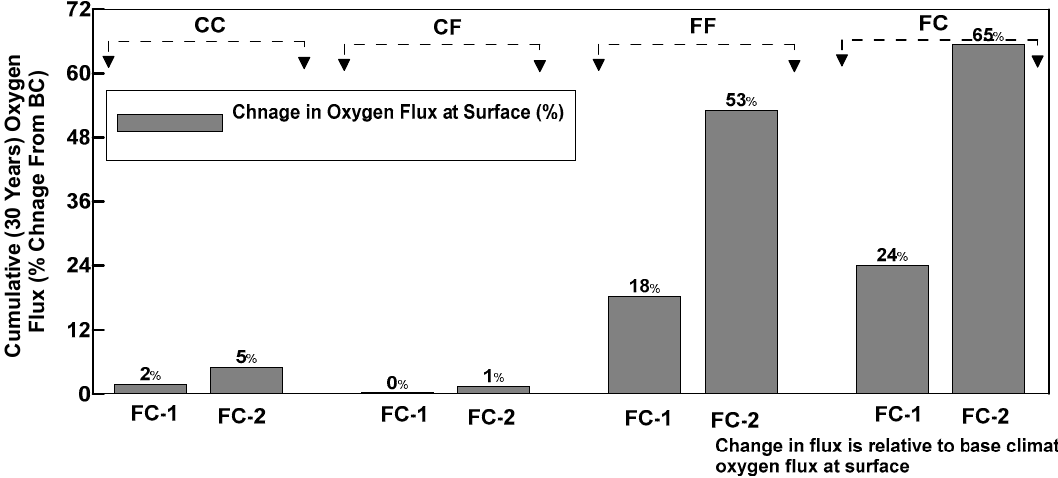
Figure 12. Change in the cumulative (30 years) oxygen flux (%) at the coarse and fine tailings covers for the base and the future climates.